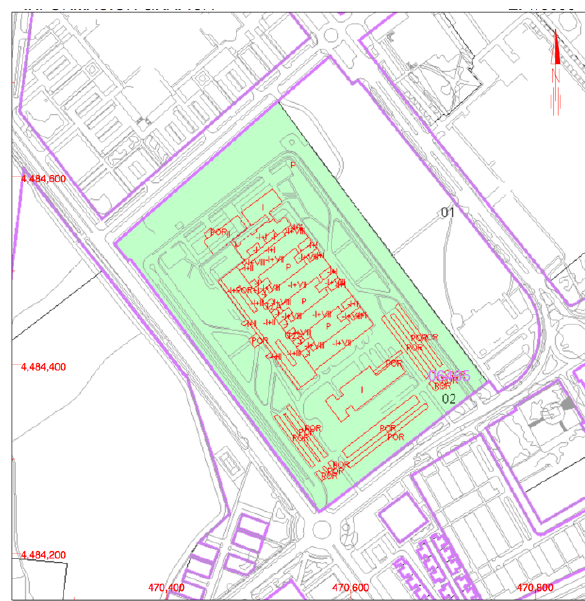
Figure 3. Cadastral map of the University Hospital Príncipe de